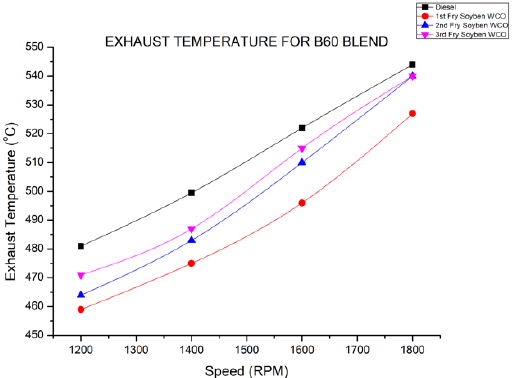
Figure 12. Exhaust temperature of different fry oils (B60 blend) at different rpm.